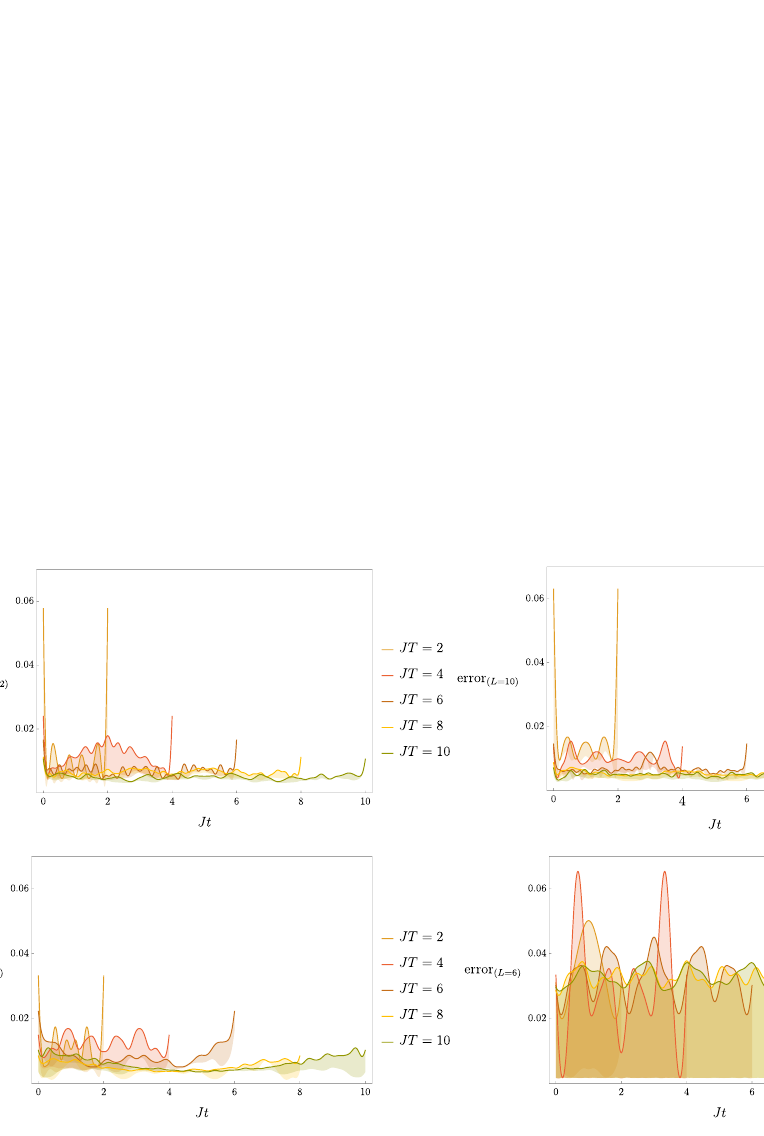
Figure 7: The same as in figure 5 for the system of figure